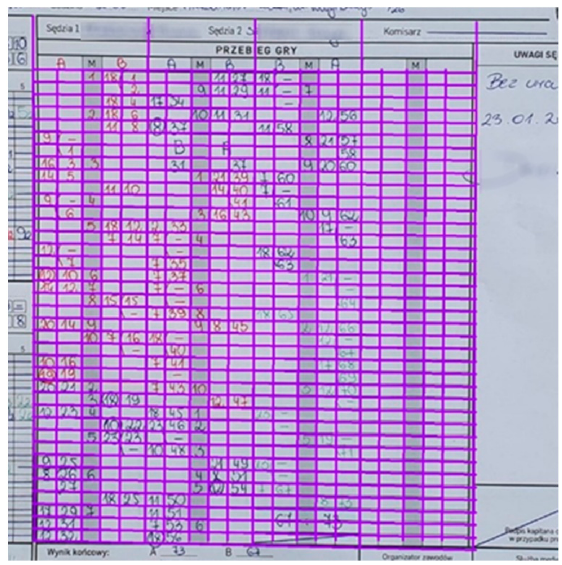
Figure 9. Identification of lines in the gameplay section.